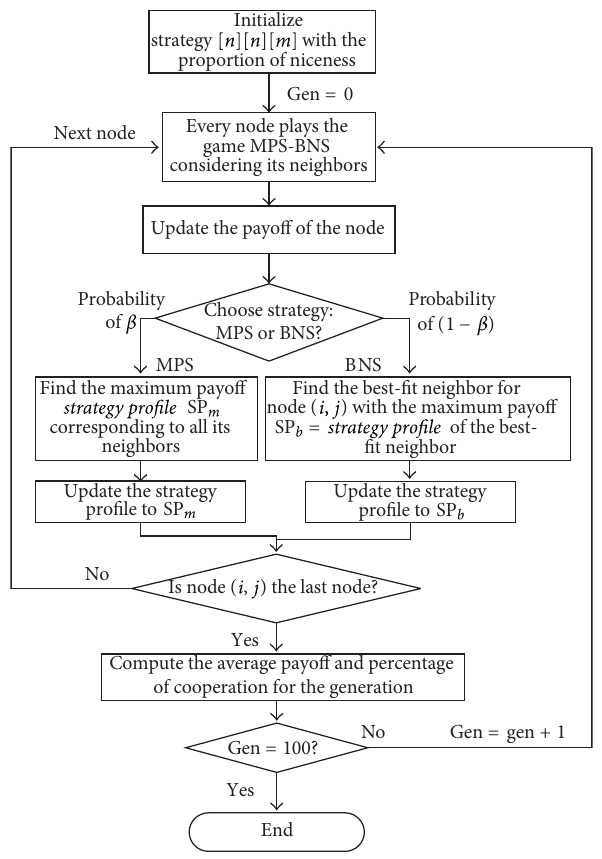
S 5: e game of MPS-BNS as mixed